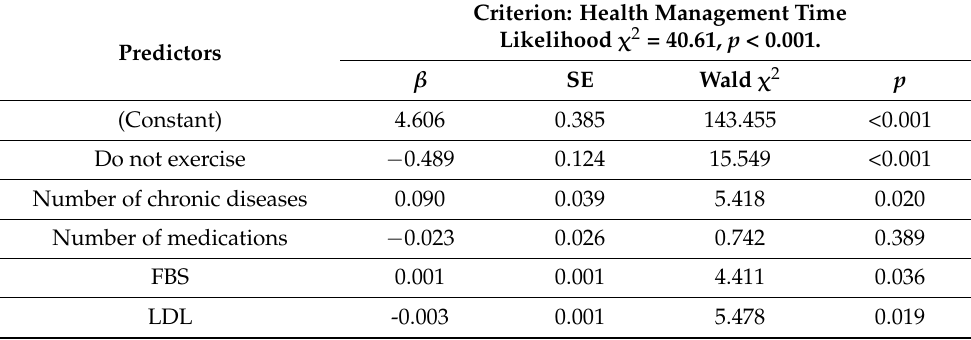
Table 5. Factors related to the life satisfaction of older